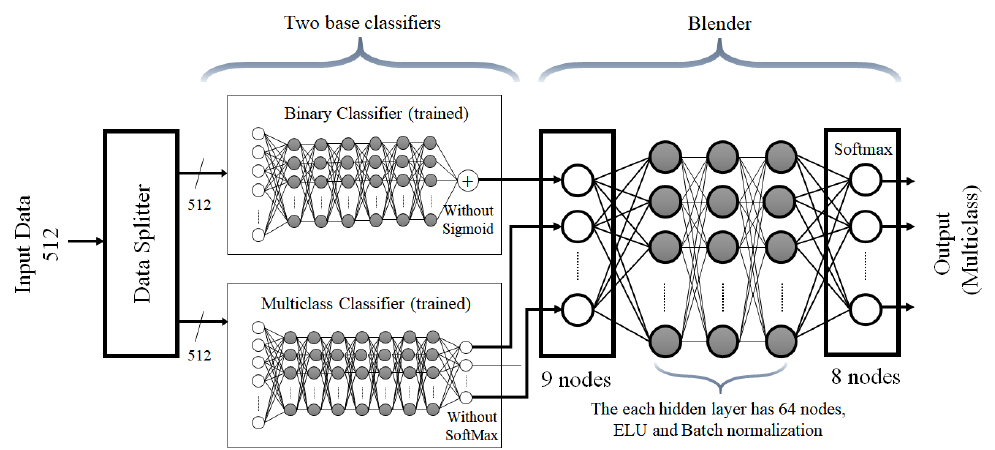
Figure 7. The designed stacking method structure: The blender combines the binary classifier with the multiclass classifier that has already been